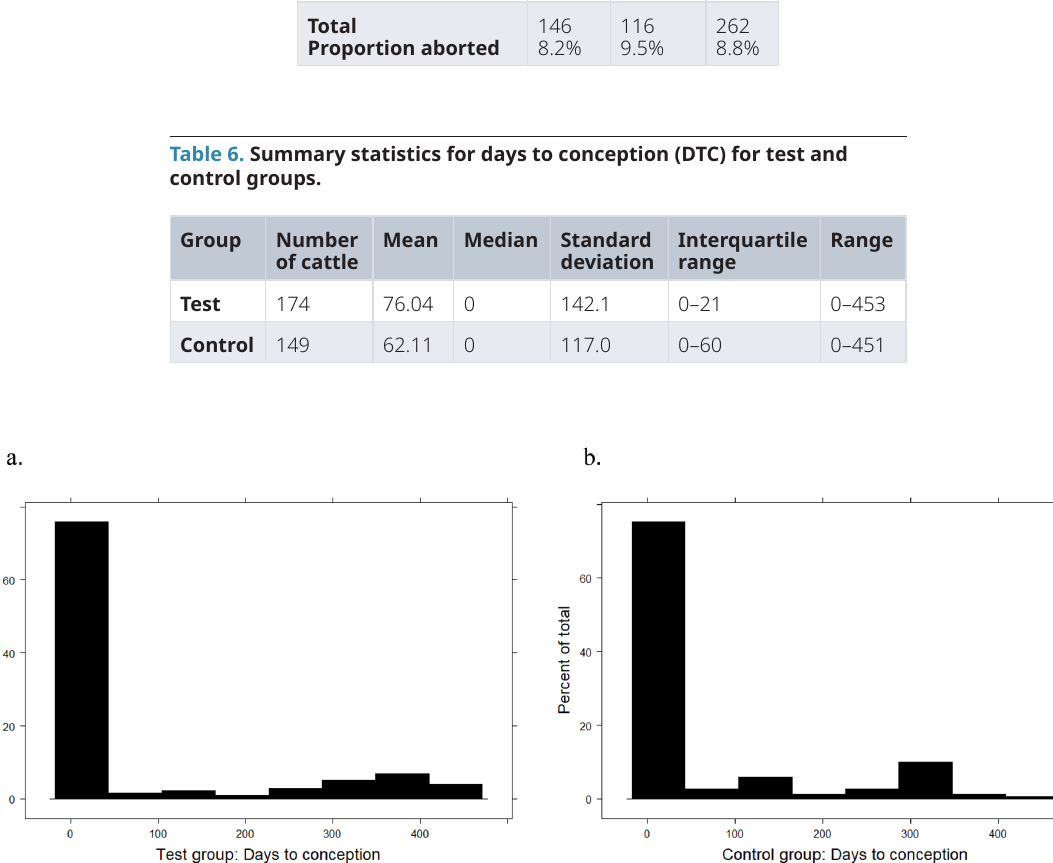
Figure 3. Summary statistic histograms of days to conception for a) test and b) control groups. Frequency (%) is on the y-axis and number of days on the